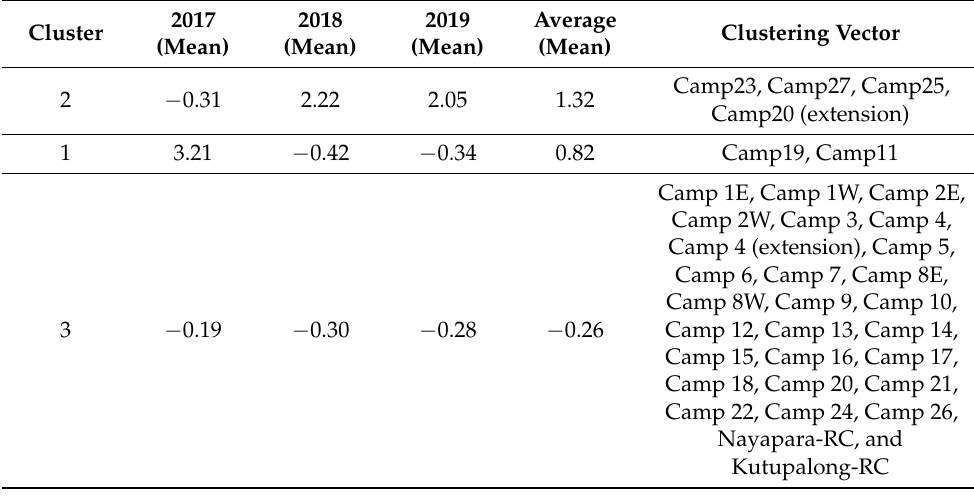
Figure 11. Clustering results of vegetative vulnerable refugee camps in Ukhiya-Teknaf in Bangladesh between 2017 and 2019. The results show the PCGA dataset grouped into three clusters. Besides, dim1 (53.5%) and dim2 (30.6%) explain that 53.5% variance within the PCGA dataset is captured by Principal Component Analysis 1 (PCA 1), while PCA 2 demonstrates 30.6% variance of the dataset. Table 6. K-means classification results of PCGA, clustering vector groups, mean values, and the average mean value of each cluster, lower values represent high vulnerability, and higher values represent low vulnerability.